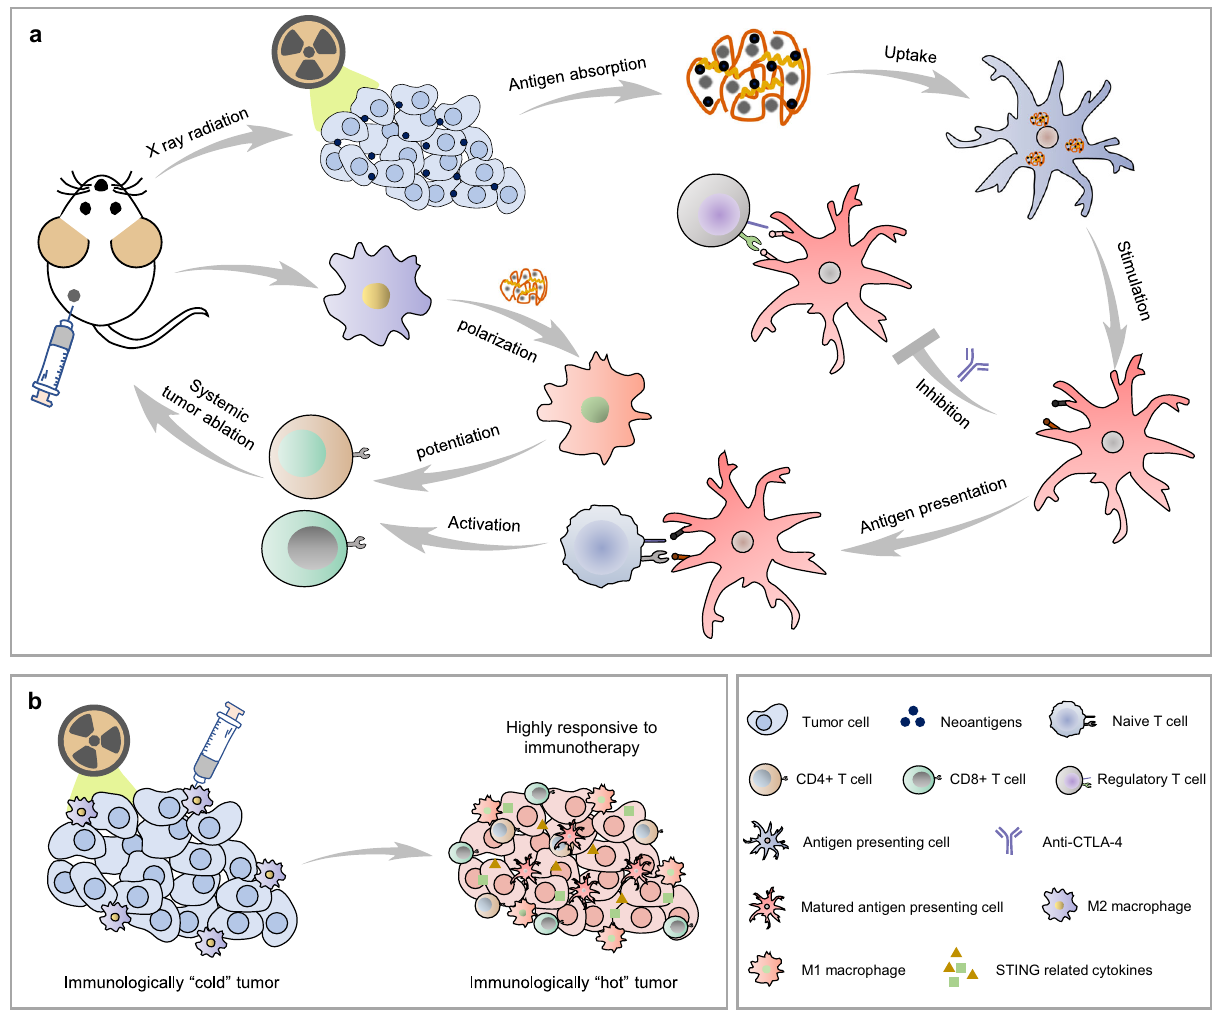
Fig. 8 | Schematic illustration ofthemechanisms whereby the multifunctional PIC may potentiate the in situ vaccination effect of RT. a The proposed mechanismsofactionforPICinpotentiatingtheinsituvaccinationeffectofRT.PIC can sensitize tumor cells to RT, capture TAAs released from dying tumor cells, promote the uptake of these captured TAAs in APCs, activate and mature APCs,